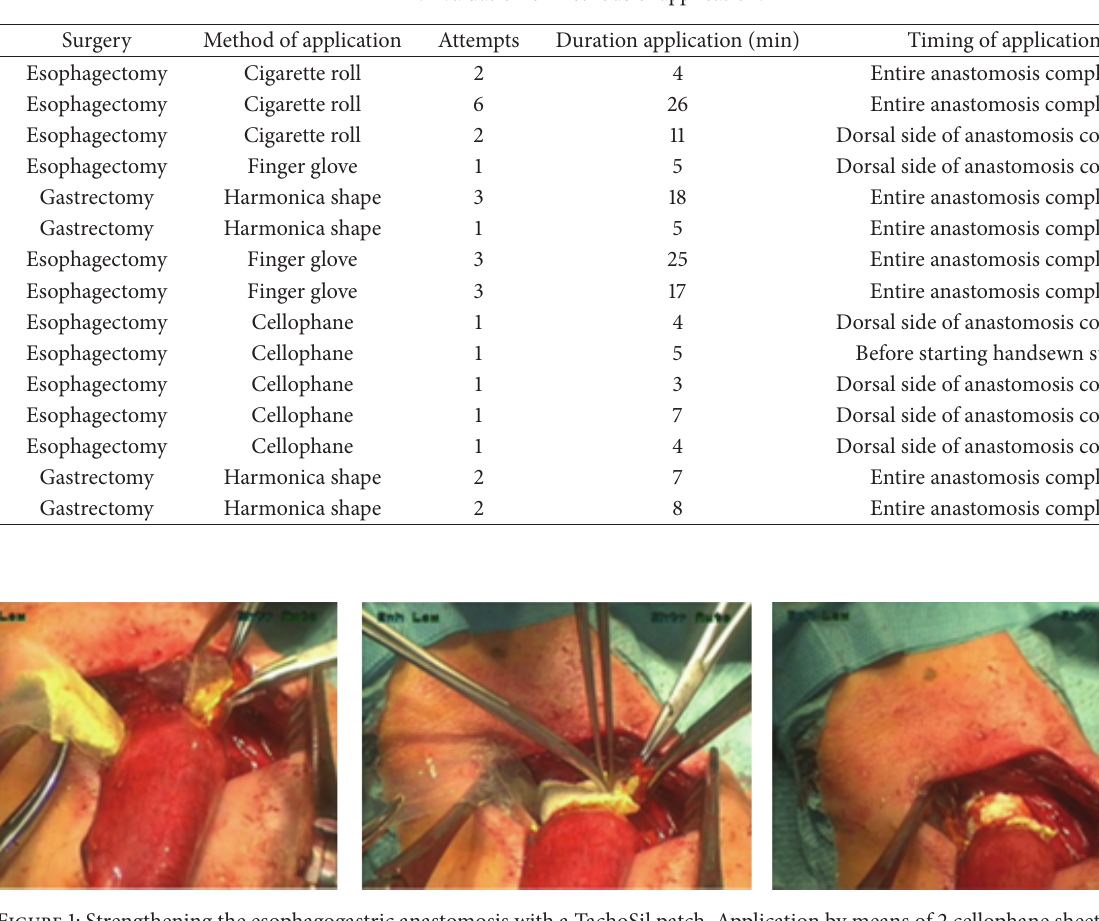
elasticity and open shape, the patch attracted fluid, resulting in increased adhesive